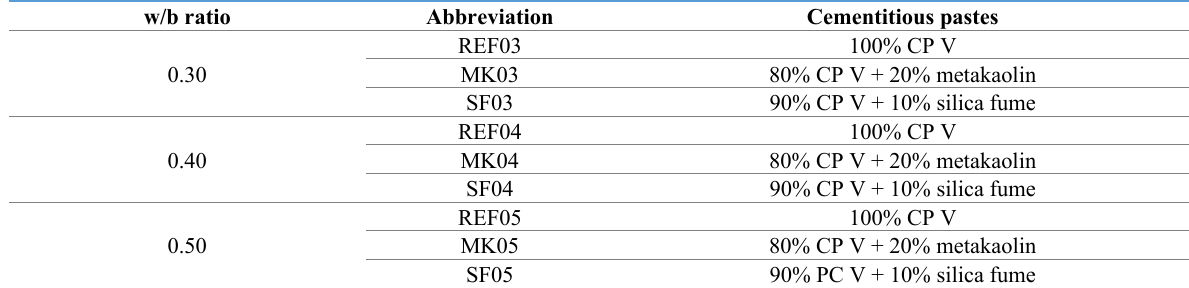
Table 4. Nomenclature and composition of the